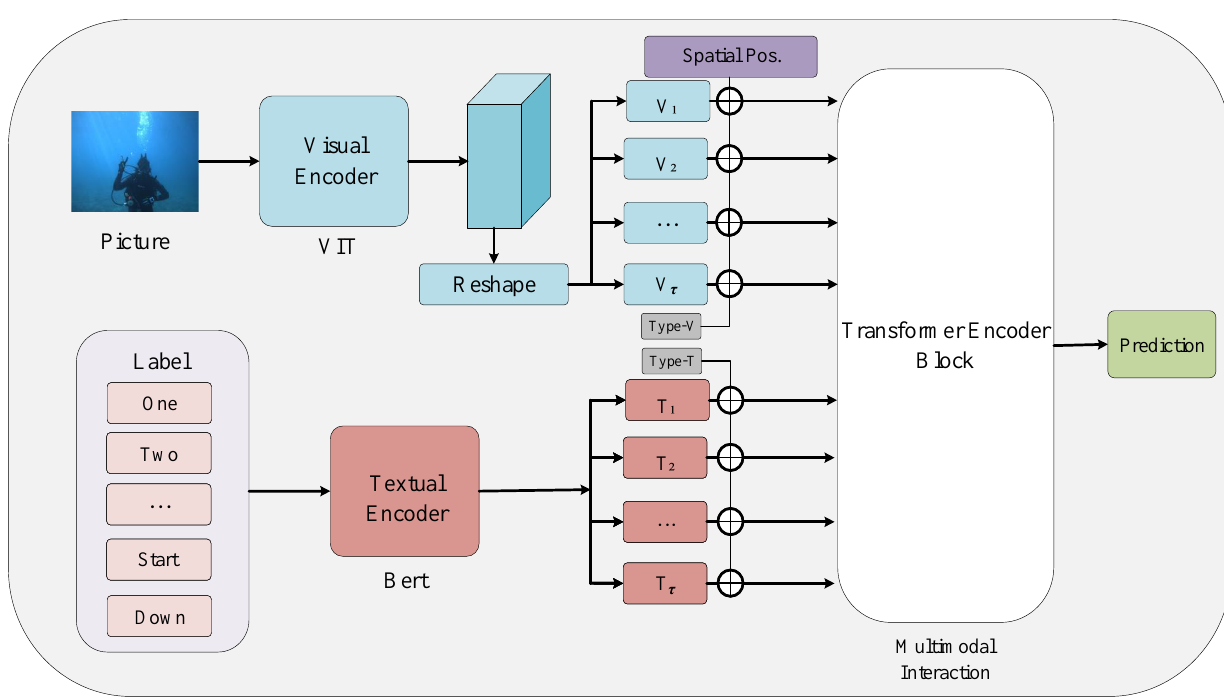
Figure 3. An overview of our proposed visual-textual baseline